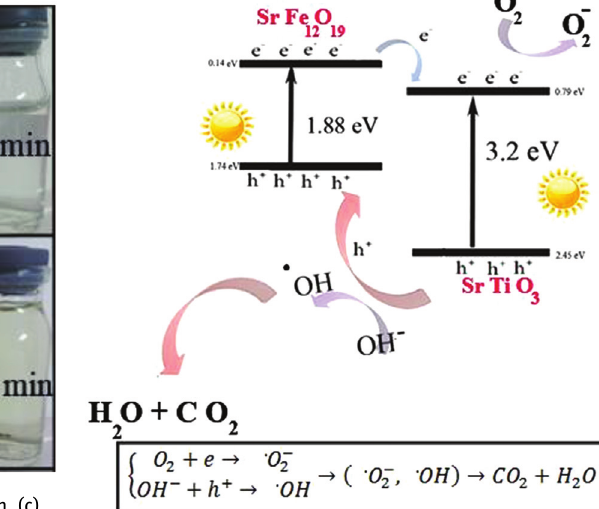
Figure 21: Photo-catalyst mechanism of SrFe case of degradation of toxic Debye-Scherrer and Williamson-Hall method. The FTIR spectrum of the SrFe Sr–O band peaks. FTIR spectrum of SrTiO indicates the band of Ti–O and Sr–O peaks. Also, in the